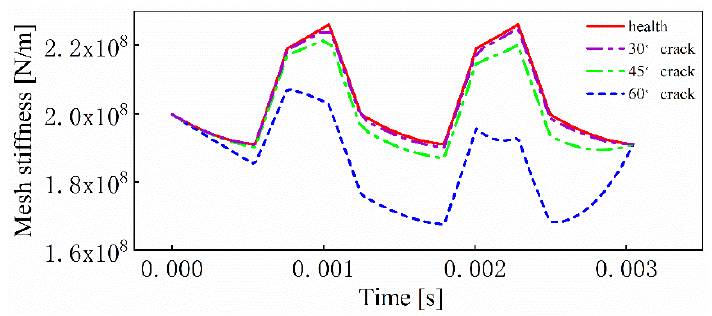
Figure 6. Stiffness values at different crack angles.